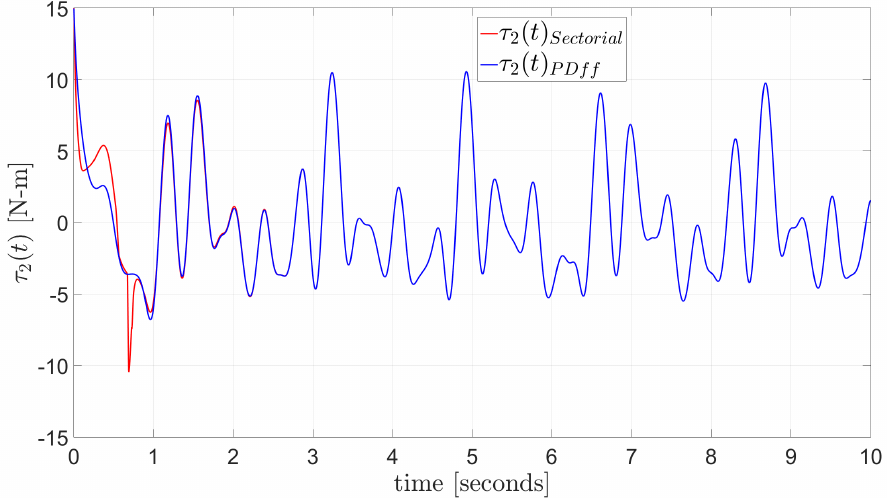
Figure 18. Applied torque to joint 2, without Coulomb friction.